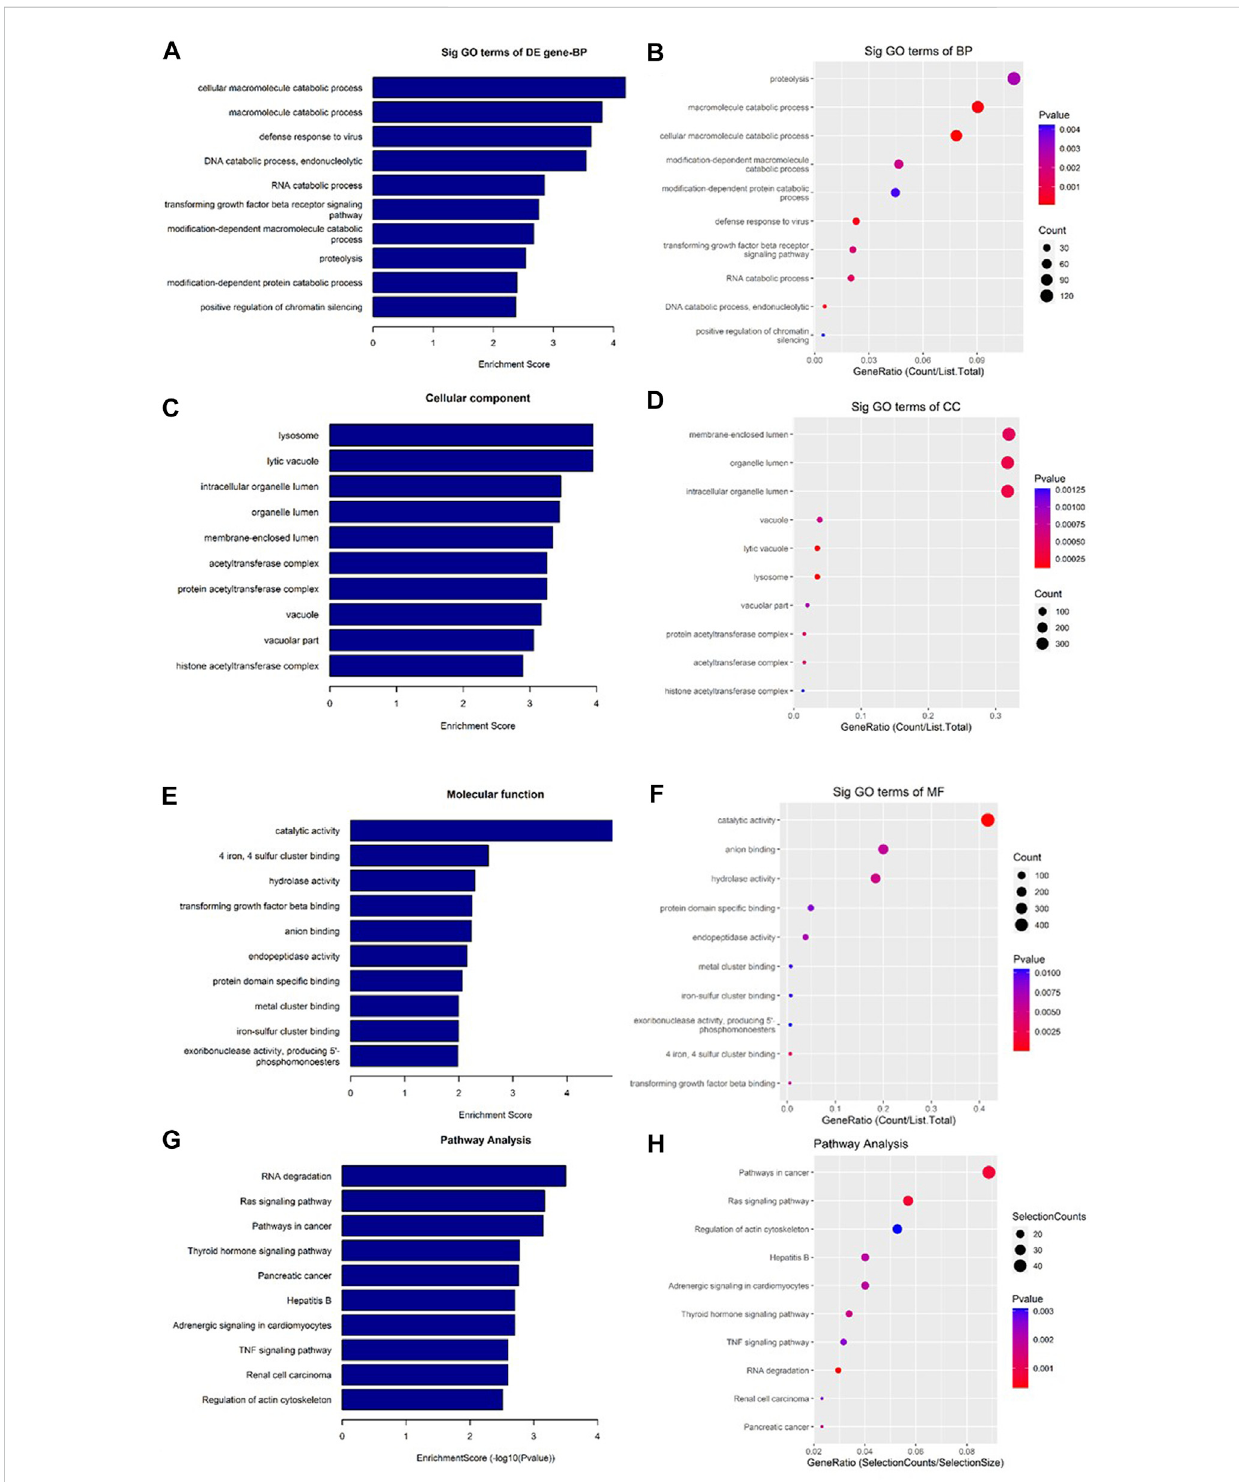
FIGURE 7 GeneOntology(GO)andKyotoEncyclopediaofGenesandGenomes(KEGG)pathwayanalysesofdownregulatedmRNAsintheGO-AgNPstreated caprine fetal fi broblast cells (CFFCs). GO analysis identi fi ed biological process (BP), cellular component (CC) and molecular function (MF) with the enrichmentscore[ (A,C,E) respectively]andgenecount (B,D,F) ,ThetoptenenrichedKEGGpathwaysofsigni fi cantlyalteredmRNAgenes (G,H) .Thecolor intensity of the nodes shows the degree of enrichment of this analysis. The enrich-factor is de fi ned as the ratio of the differential genes in the entire genome. The dot size represents the count of genes in a